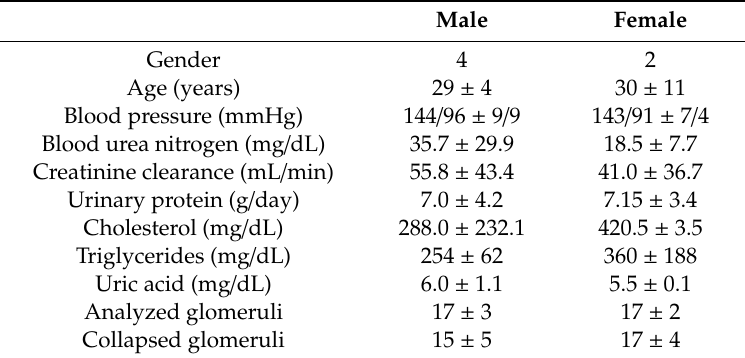
Table 1. General characteristics of patients with collapsing